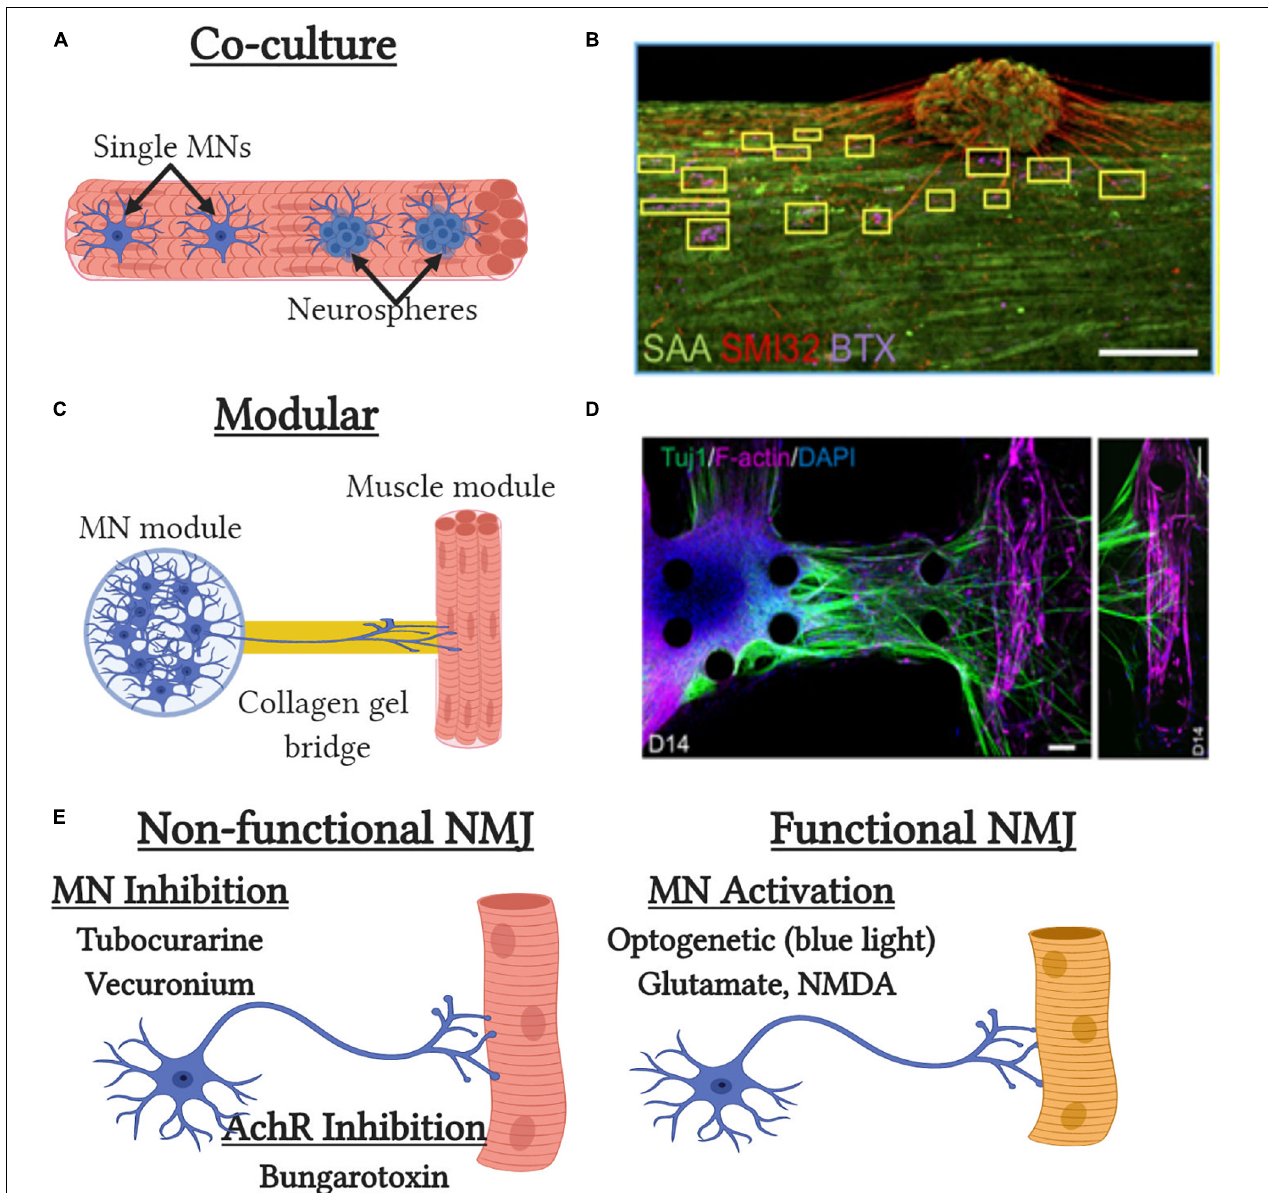
FIGURE 3 | Tissue-engineered neuromuscular junction (NMJ) models. (A) Traditional co-culture NMJ models where single MNs or neurospheres are embedded with muscle cells at the time of tissue formation. (B) Representative image of the co-culture NMJ model (Afshar Bakooshli et al., 2019) with immunofluorescent staining of neurite extensions (SMI32), acetylcholine receptors [ α -bungarotoxin (BTX)] and muscle sarcomeres [sarcomeric α -actinin (SAA)]. Scale bar, 200 µ m. (C) Modular NMJ muscle model where motor neurons (MNs) and engineered muscle tissues are cultured in separate compartments and connected by a collagen gel which supports neurite extension. (D) Representative image of the modular NMJ model (Osaki et al., 2018b) with immunofluorescent staining of neurite extensions (TUJ1) and myotubes [filamentous(f)-actin]. Scale bars, 100 µ m. (E) Schematic depicting pharmacological and genetic methods to assess neuromuscular junction (NMJ) functionality in vitro